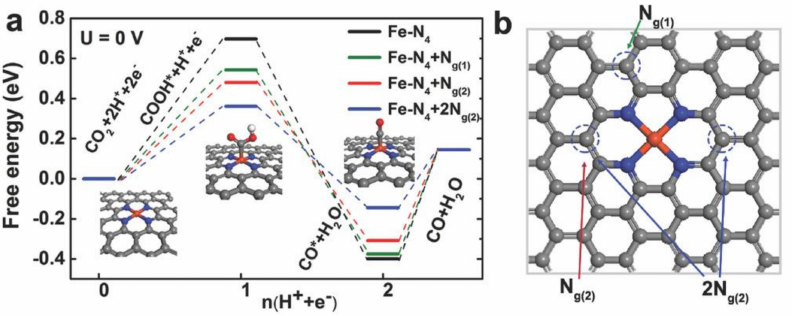
Figure 9. Fe–N 4 as effective active sites for the CO 2 RR to CO. ( a ) Free energy vs. reaction path graph for the CO 2 RR to CO on different Fe–N 4 centers for the Fe/NG catalyst. ( b ) Top view-scheme of the Fe/NG catalyst highlighting the Fe–N 4 center (Fe atom in red, N atoms in blue) and the potential nitrogen-substitute atoms. Reprinted with permission from Ref. [71]. Copyright 2022 John Wiley and